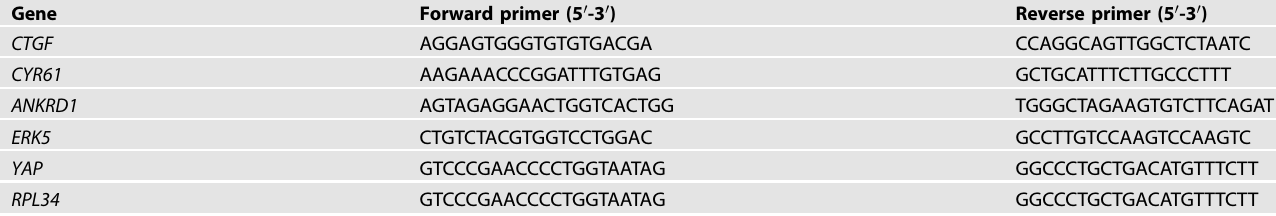
Table 2. List of human primers used for RT-qPCR